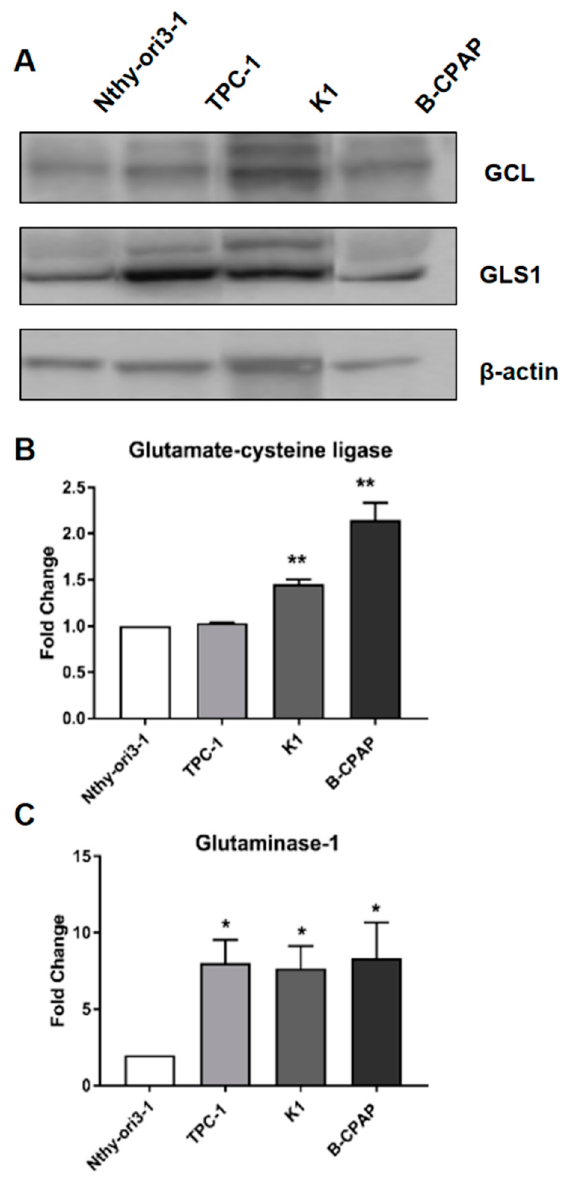
Figure 5. Expression of glutamate-cysteine ligase and glutaminase 1 . ( A ) Western blot of both glutamate-cysteine ligase (GCL) and GLS1 with the reference gene β -actin. ( B ) Expression of glutamate-cysteine ligase in PTC-derived and control cells. ( C ) Expression of glutaminase-1 in PTC-derived and control cells. Data are expressed as fold change of expression in the control cells, and were normalized to actin as reference gene. All experiments were performed three times independently, each time in triplicate to confirm the results. Statistical analysis were performed by Student’s t -Test. Results were considered significant when * p < 0.05, ** p < 0.01, *** p < 0.001.